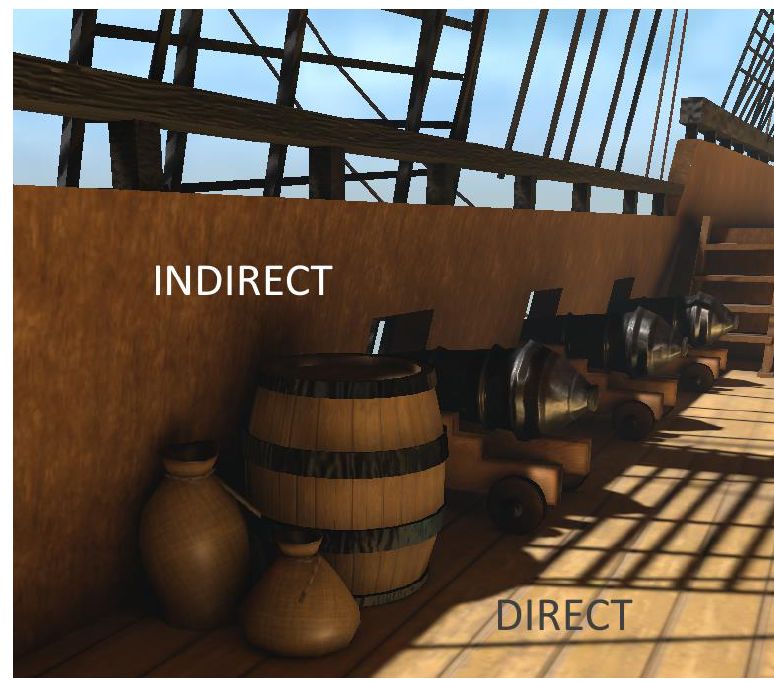
Figure 14 . Direct and indirect lighting. Figure 14. Direct and indirect